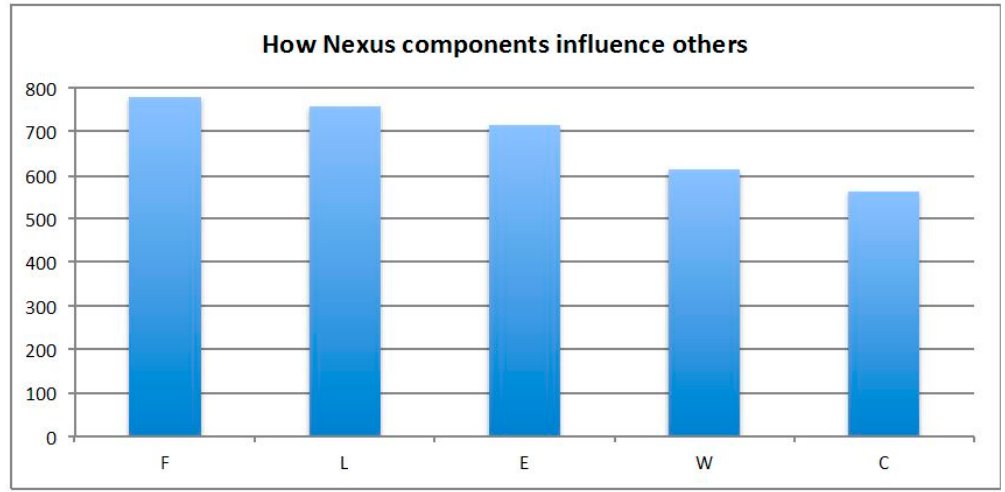
Figure 7. Nexus components and influence scores showing how nexus components influence others.